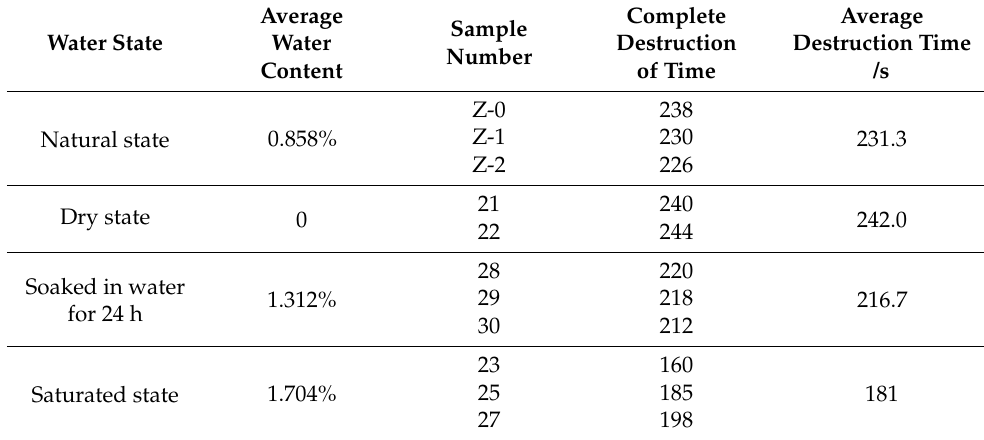
Table 2. Water content and failure time of the sample.